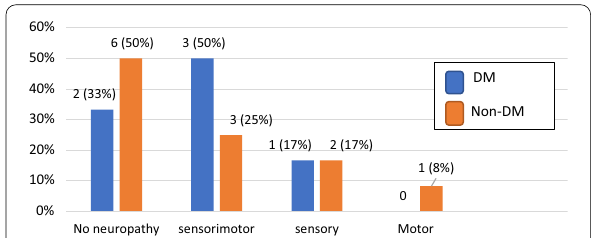
Fig. 1 Comparison of the clinical neuropathy pattern between diabetic and non-diabetic patients. DM diabetic patients, Non-DM non-diabetic